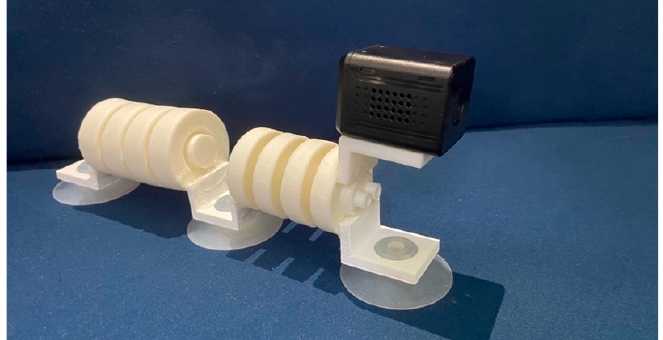
Figure 25. Camera installed on the robot.